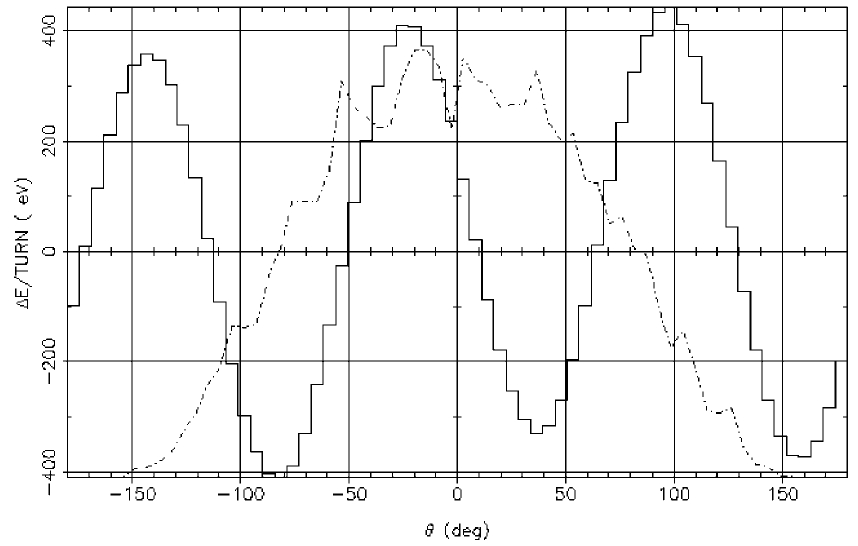
FIG. 2. The conditions are the same as in Fig. 1 scaled with l (cid:1) 2 after 2 3 10 4 iterations The voltage scale is V 0 (cid:1) l V .